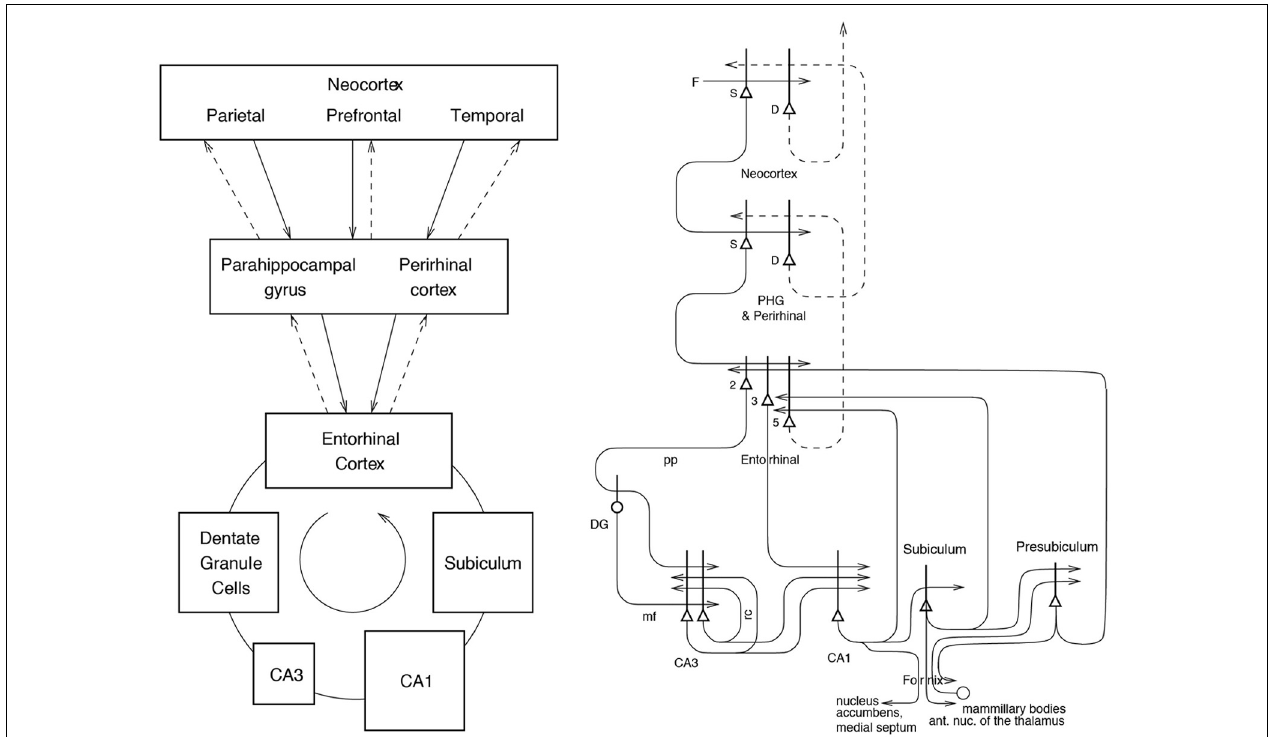
FIGURE 1 | Forward connections (solid lines) from areas of cerebral association neocortex via the parahippocampal gyrus and perirhinal cortex, and entorhinal cortex, to the hippocampus; and backprojections (dashed lines) via the hippocampal CA1 pyramidal cells, subiculum, and parahippocampal gyrus to the neocortex. There is great convergence in the forward connections down to the single network implemented in the CA3 pyramidal cells; and great divergence again in the backprojections. Left : block diagram. Right : more detailed representation of some of the principal